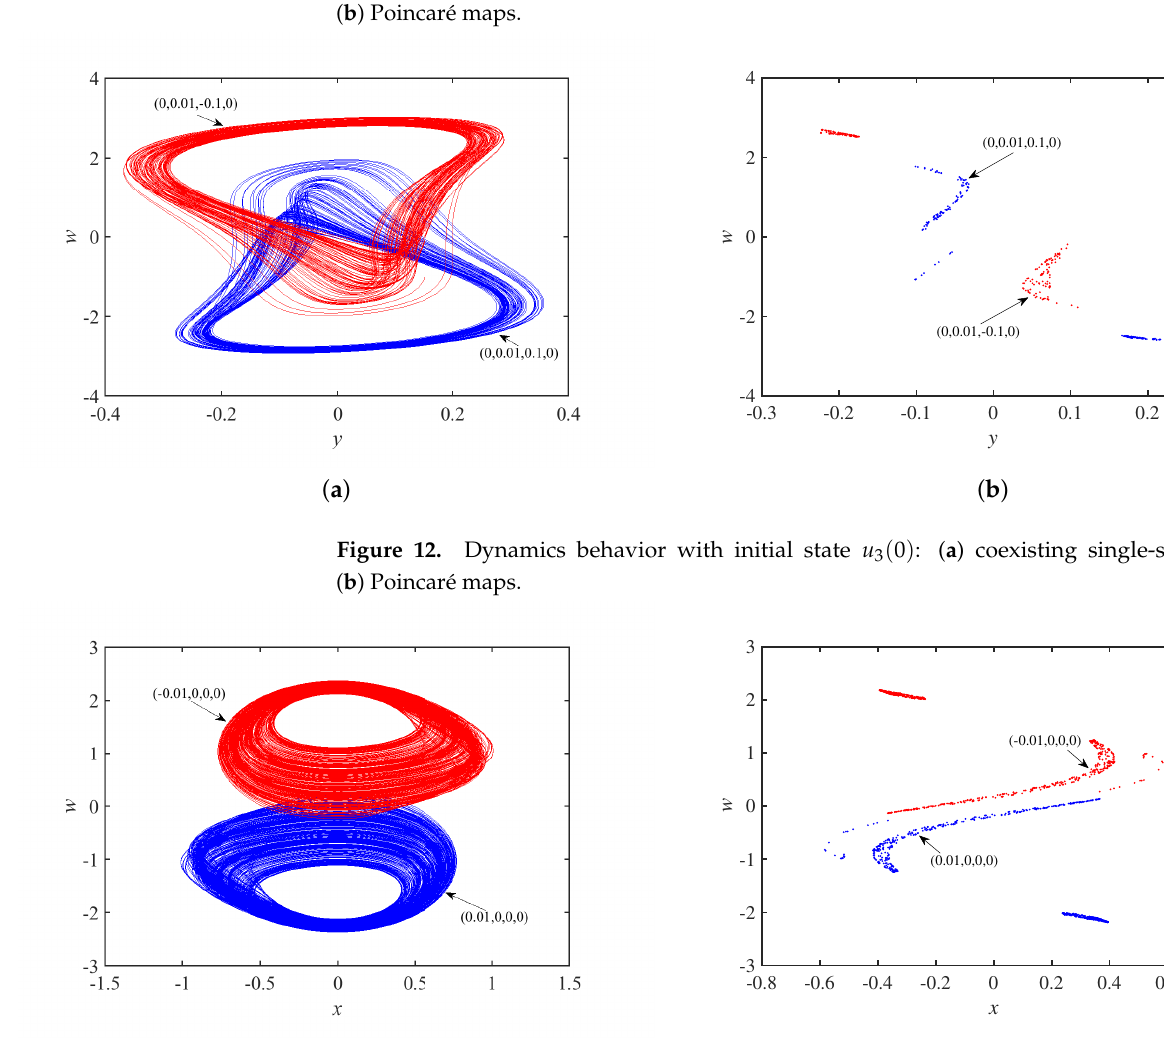
Figure 11. Dynamics behavior with initial state u 1 ( 0 ) : ( a ) coexisting single-scroll attractors; ( b ) Poincaré maps.